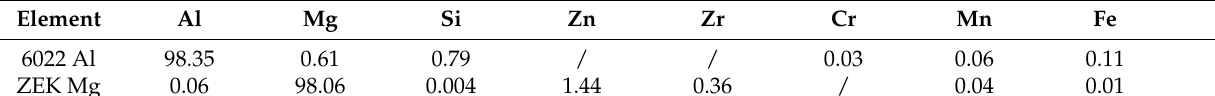
Table 1. Chemical composition of AA 6022 Al and ZEK 100 Mg (wt.%).